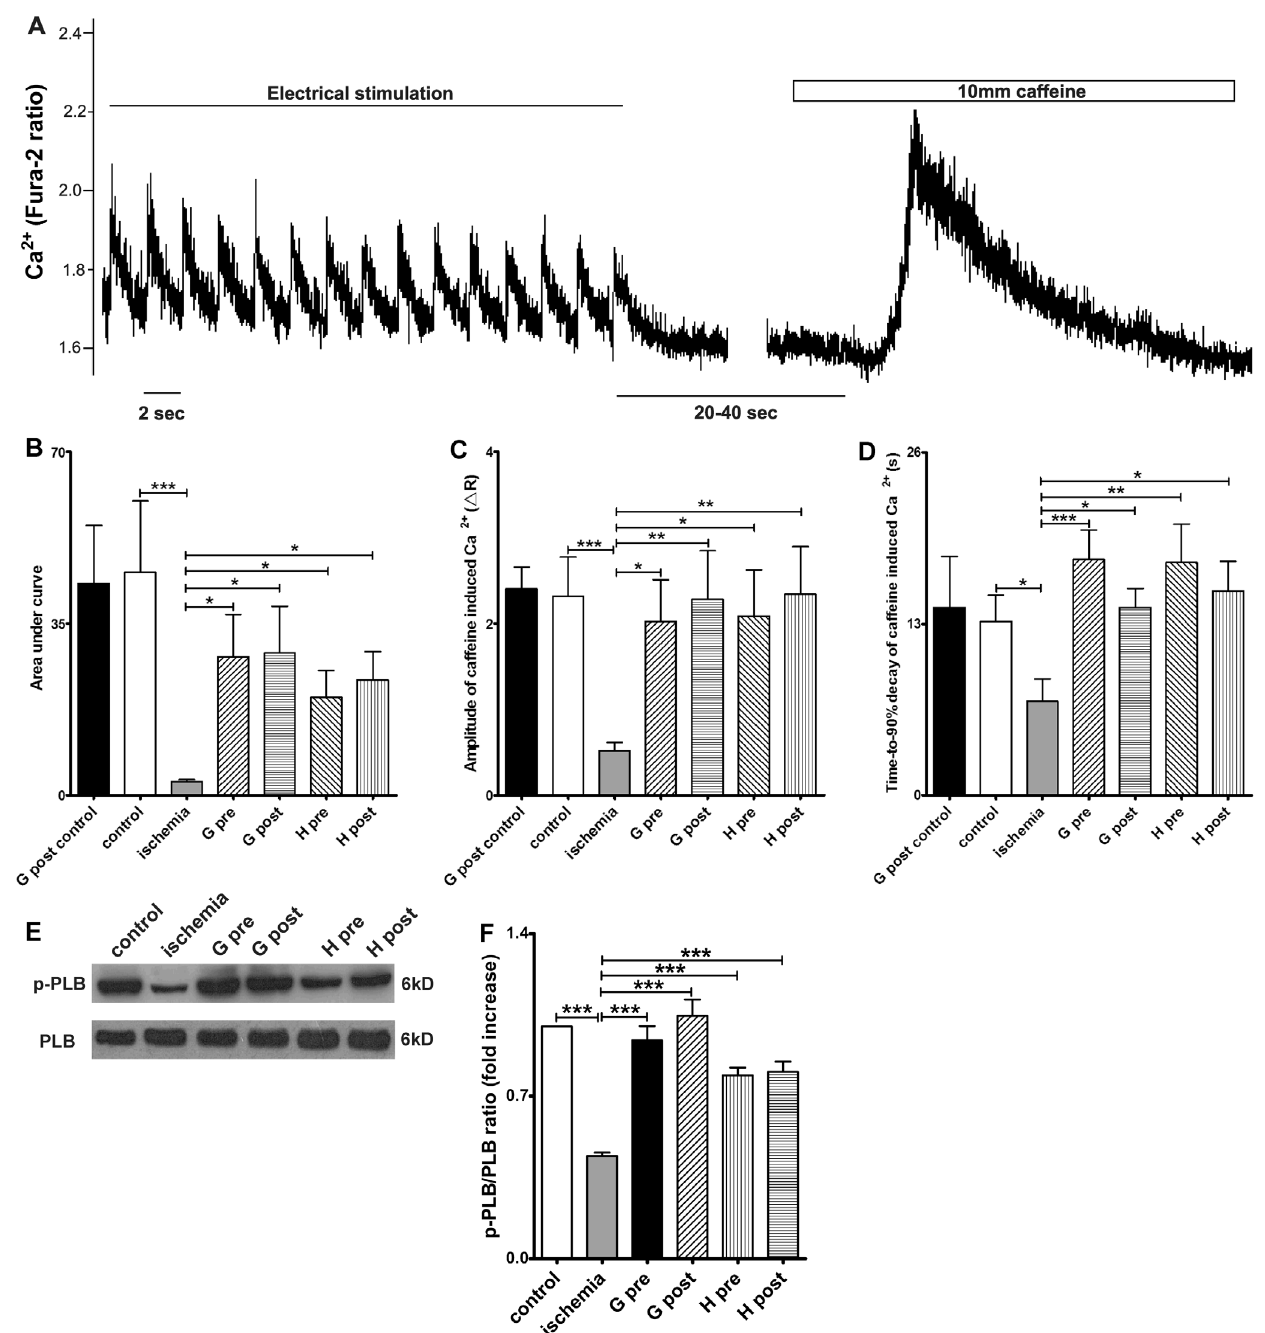
Figure 4. Effects of GHS on sarcoplasmic reticulum (SR) Ca 2 + content and phospho-phospholamban (p-PLB)/phospholamban (PLB) expression. (A) Illustration of the SR Ca 2 + content measurement protocol (data from cardiomyocytes exposed to ischemia/reperfusion). R represents the emission fluorescence ratio of fura-2 from excitation at 340 and 380nm. Cardiomyocytes were perfused with Tyrode solution containing 1.5 mM CaCl 2 and paced at 0.5 Hz for at least 30 s. 10 mM caffeine was then added to induce SR Ca 2 + release. SR Ca 2 + content, as determined by both (B) Area under curve and (C) amplitude of the caffeine-induced Ca 2 + release, significantly decreased after 20 min ischemia compared with the control group. Ghrelin (G) or hexarelin (H) pre-treatment (pre) and post-treatment (post) significantly increased the SR Ca 2 + content after 20 min ischemia (B and C), but introduction of ghrelin into the perfusion system at 40 min and lasting for 10 min (G post control) had no effect on the SR Ca 2 + content of the cells isolated from the normal perfused heart. (D) The time-to-90% decay of caffeine-induced increases in [Ca 2 + ] i mainly reflect the Ca 2 + clearance ability of the Na + /Ca 2 + exchanger (NCX). n = 18, 44, 44, 33, 38, 41 and 38 cells/3 mice in G post control, control, ischemia, G pre, G post, H pre and H post, respectively. (E) Representative western blots of the total phospholamban (PLB) and the phosphorylated PLB (p-PLB) in 6 groups and (F) the densitometric quantification of ratio of p-PLB/PLB (expressed as fold increase relative to control). n = 5 mice in each group. Data are shown as means 6 S.E.M. and analyzed by one-way ANOVA with Tukey’s post hoc test. * P , 0.05, ** P , 0.01, *** P , 0.001 vs ischemic group.